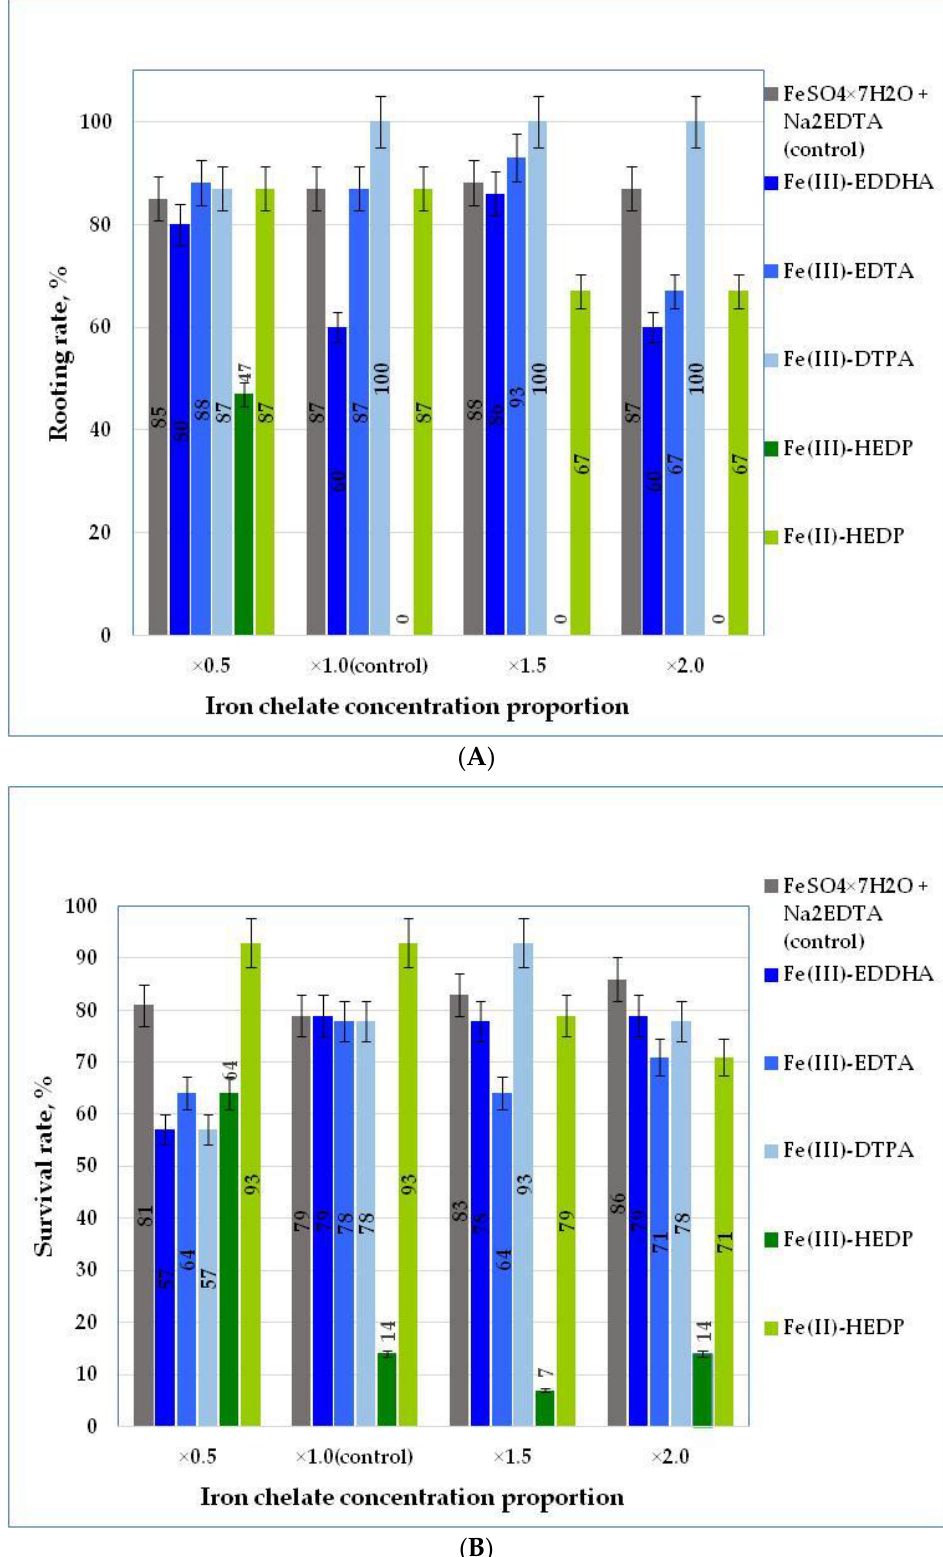
Figure 3. Rooting rate at the stage of rooting ( A ) and microplants’ survival rate at the acclimatization stage ( B ) of blue honeysuckle “Lulia” ( Lonicera caerulea var. kamtschatica Sevast.) depending on the iron chelate type in the MS nutrient medium.